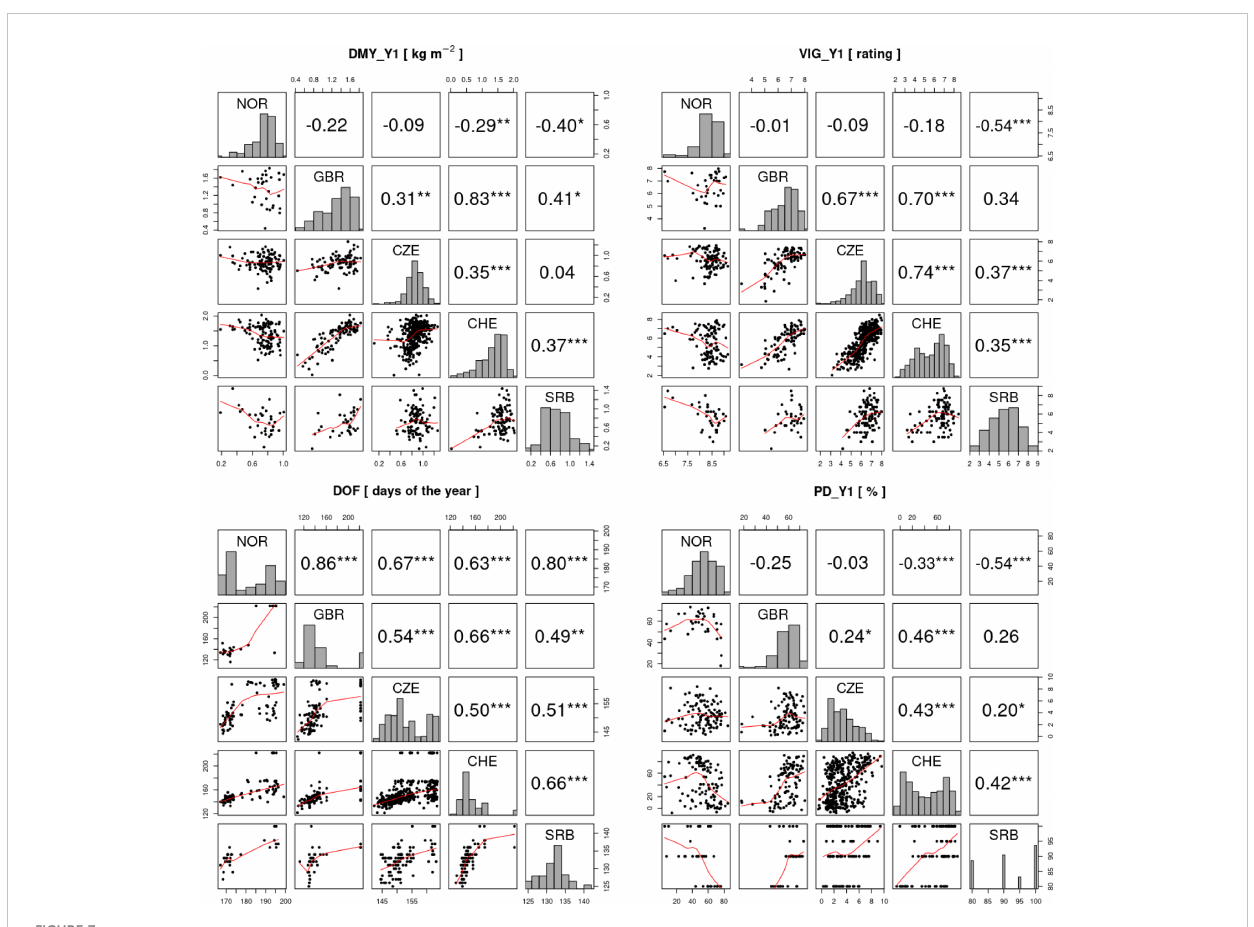
FIGURE 7 Correlation analysis of the traits total dry matter yield in the fi rst year (DMY_Y1), average vigor in the fi rst year (VIG_Y1), date of fl owering (DOF) and plant density after the fi rst year (PD_Y1) in the fi ve fi eld trial locations. In the diagonal, histograms of the trait values for each trial location are shown. Above the diagonal, Pearson correlations between trials are shown and signi fi cant correlations are indicated by asterisks (*p< 0.05, ** p< 0.01, *** p< 0.001). Below the diagonal, trait values of the two trials are plotted against each other with the red line representing the LOESS (locally estimated scatterplot smoothing)